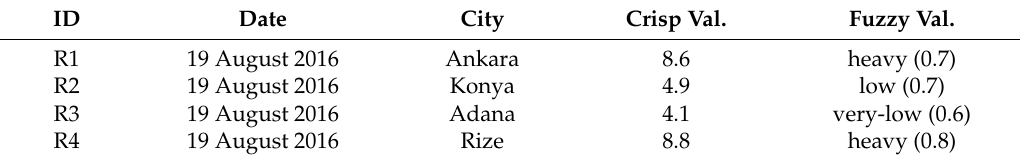
Table 4. Sample data for rainfall in database.